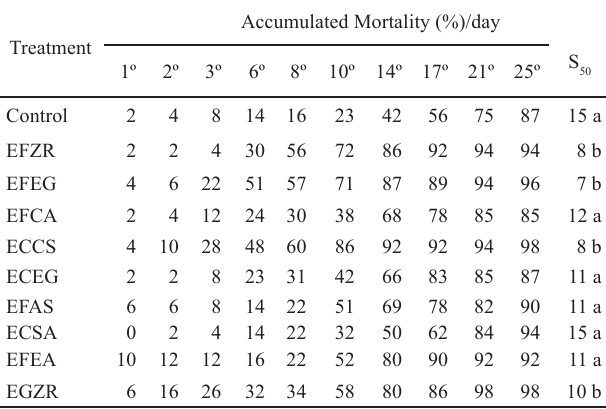
Table 3 . Mortality (%) and average survival period (S Atta sexdens sexdens (Hymenoptera: Formicidae) workers fed on diet containing several plant extracts at the concentration of 0.2 mg.mL -1